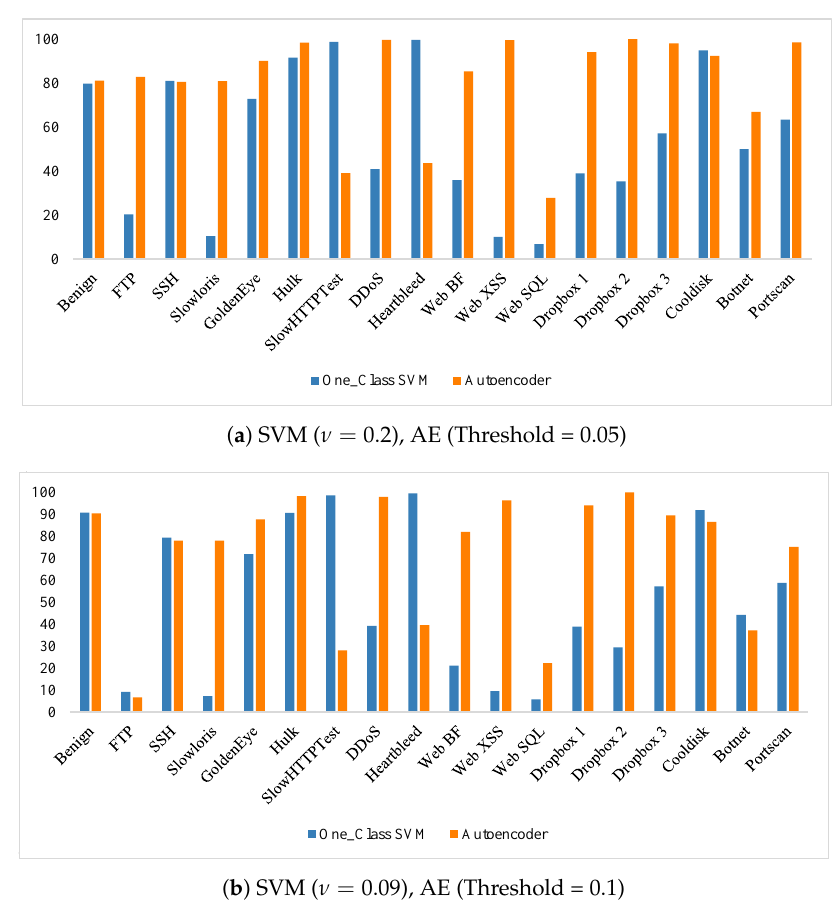
Figure 4. CICIDS2017 Autoencoder, One-Class SVM